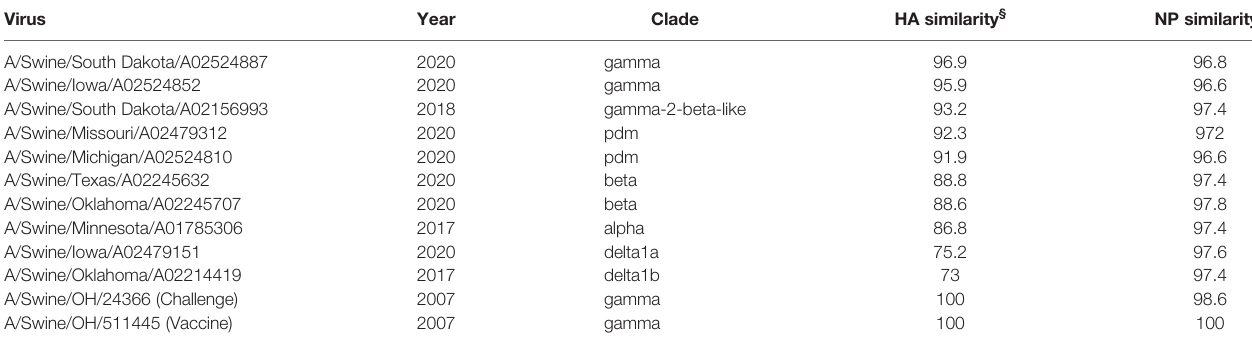
TABLE 4 | Description of the isolates used in cross-neutralization assay.